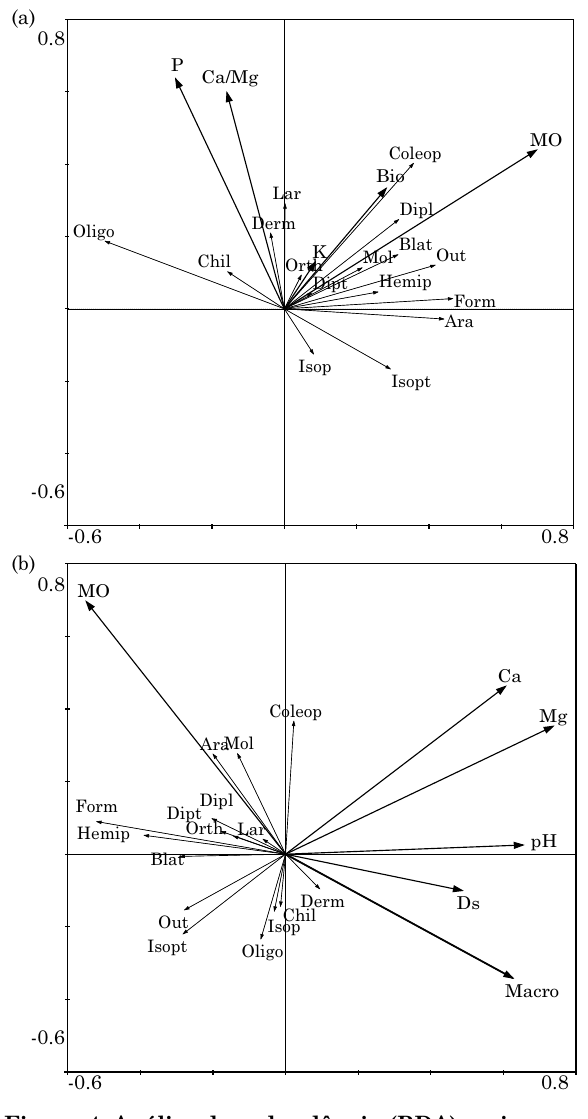
Figura 4. Análise de redundância (RDA) no inverno (a) e verão (b) de 2011, independentemente do sistema de uso do solo (sus), na região do Planalto sul-catarinense. formicidae (form); Dermaptera (Derm); chilopoda (chil); oligochaeta (oligo); isopoda (isop); isoptera (isopt); araneae (ara); larvas (lar); Diptera (Dipt); coleoptera (coleop); Diplopoda (Dipl); Blattodea (Blat); Molusca (Mol); Hemiptera (Hemip); somatório de grupos menos frequentes (out); Matéria orgânica (Mo); fósforo (P); Relação Cálcio/Magnésio (Ca/Mg); Alumínio (Al); Bioporos (Bio); Acidez ativa (pH); Cálcio (ca); Magnésio (Mg); Densidade do solo (Ds); e Macroporosidade